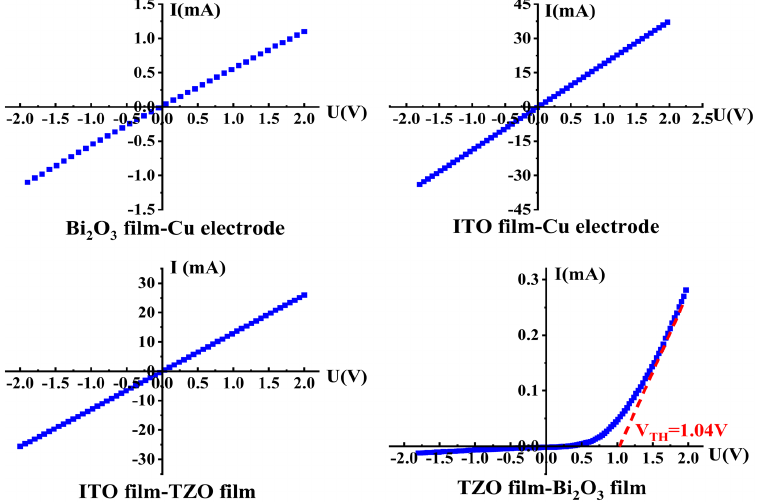
Figure 7. I–V measurement curve of adjacent layer of TZO/Bi 2 O 3 heterojunction